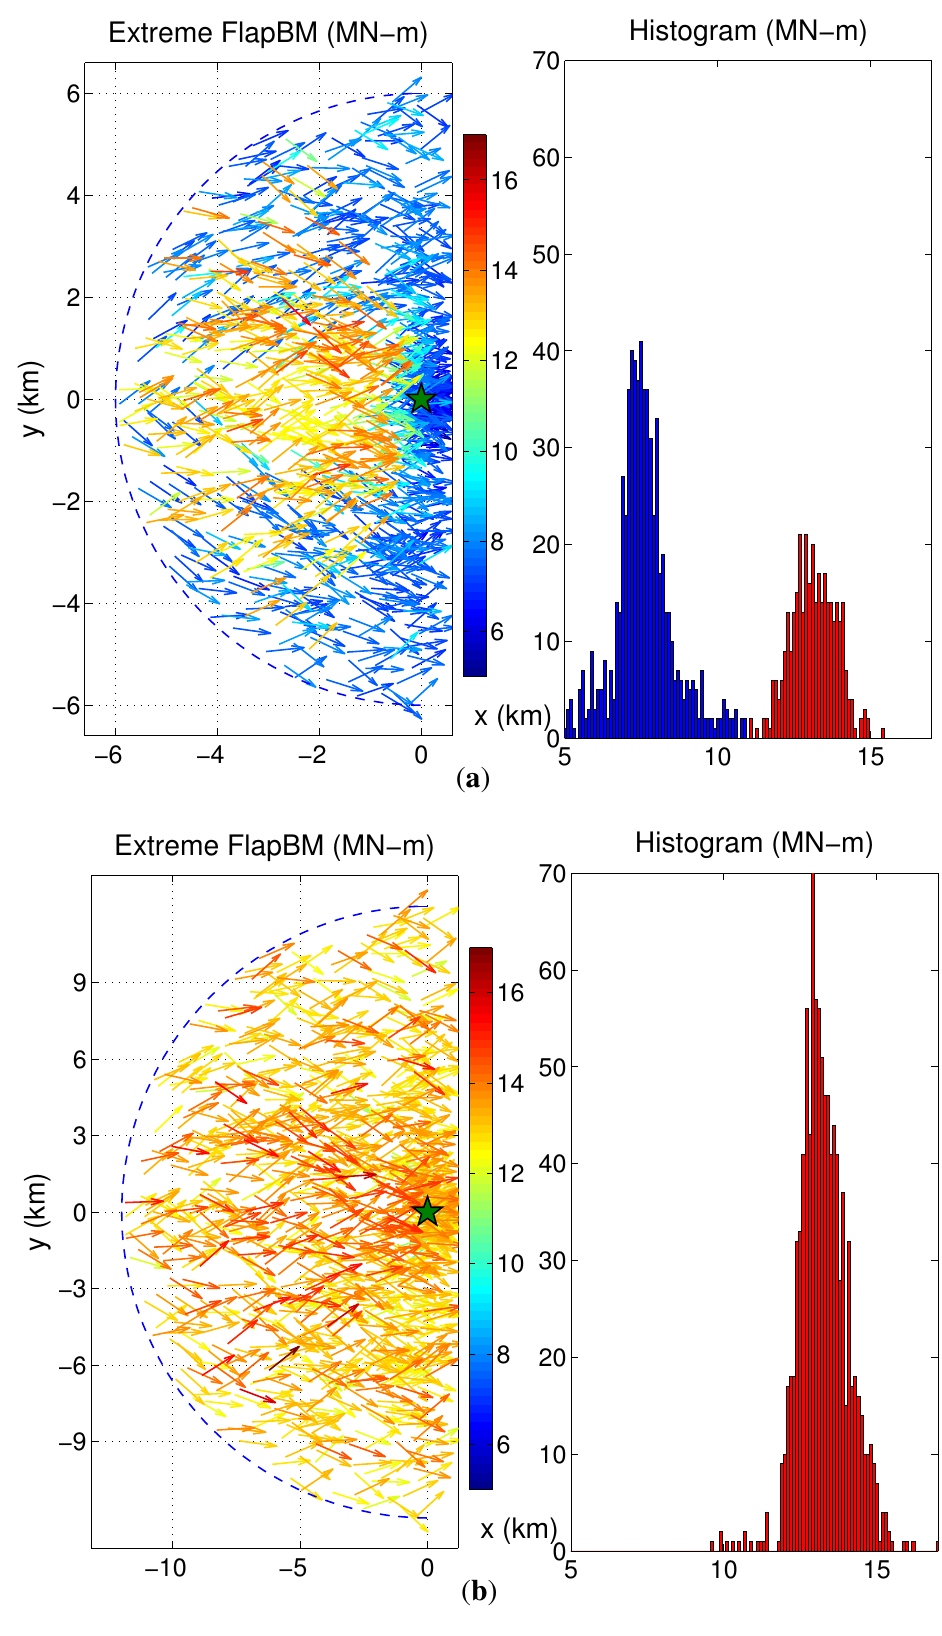
Figure 9. Extreme flapwise bending moment (MN-m) at a blade root accounting for uncertainty in storm touchdown location and translation direction. ( a ) JAWS “Average” downburst; ( b ) NIMROD Yorkville